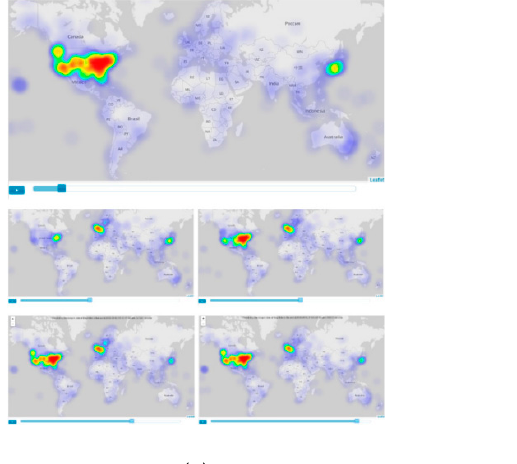
Figure 17. Comparison between general heatmaps ( left ) and reverse heatmaps ( right ) of Beijing urban area [51].